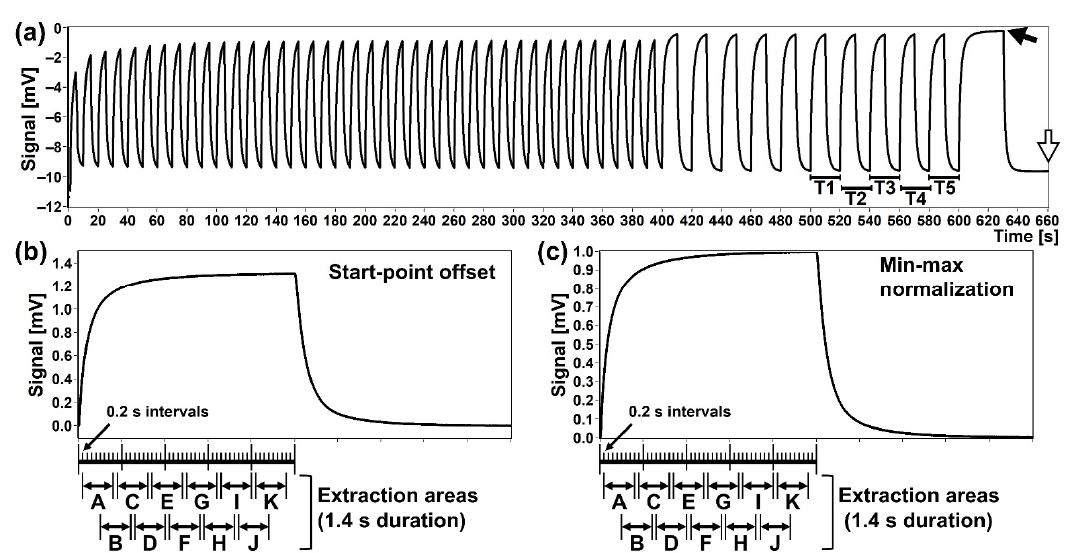
Figure 4. An example of an output waveform measured by the MSS measurement module. ( a ) A sequence of output waveforms. The last five of the 10 s cycles (denoted as T1–T5) were selected for the analysis. The black and white arrows indicate the measurement points of temperature and relative humidity (RH), in the sample and purge gases, respectively. ( b , c ) Examples of the output waveforms processed by the start-point offset method ( b ) and by the min-max normalization method ( c ). Data extraction areas were set as indicated by A–K.